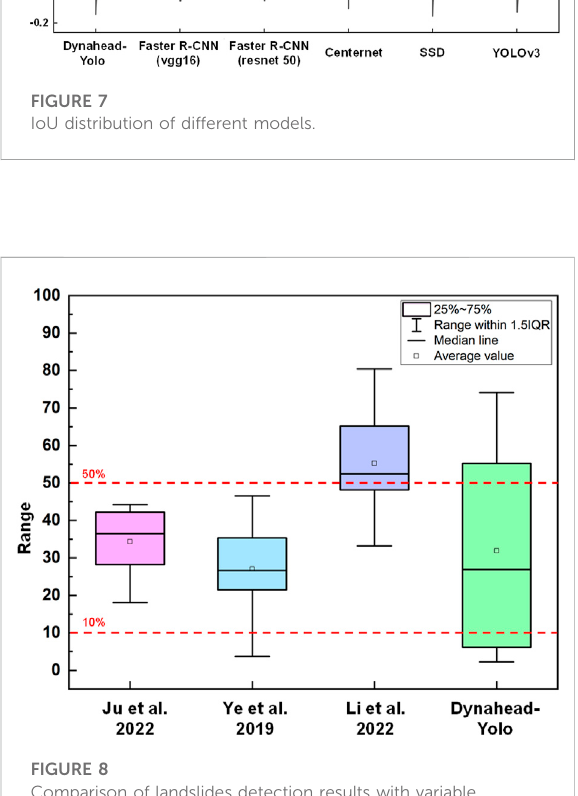
FIGURE 8 Comparison of landslides detection results with variable